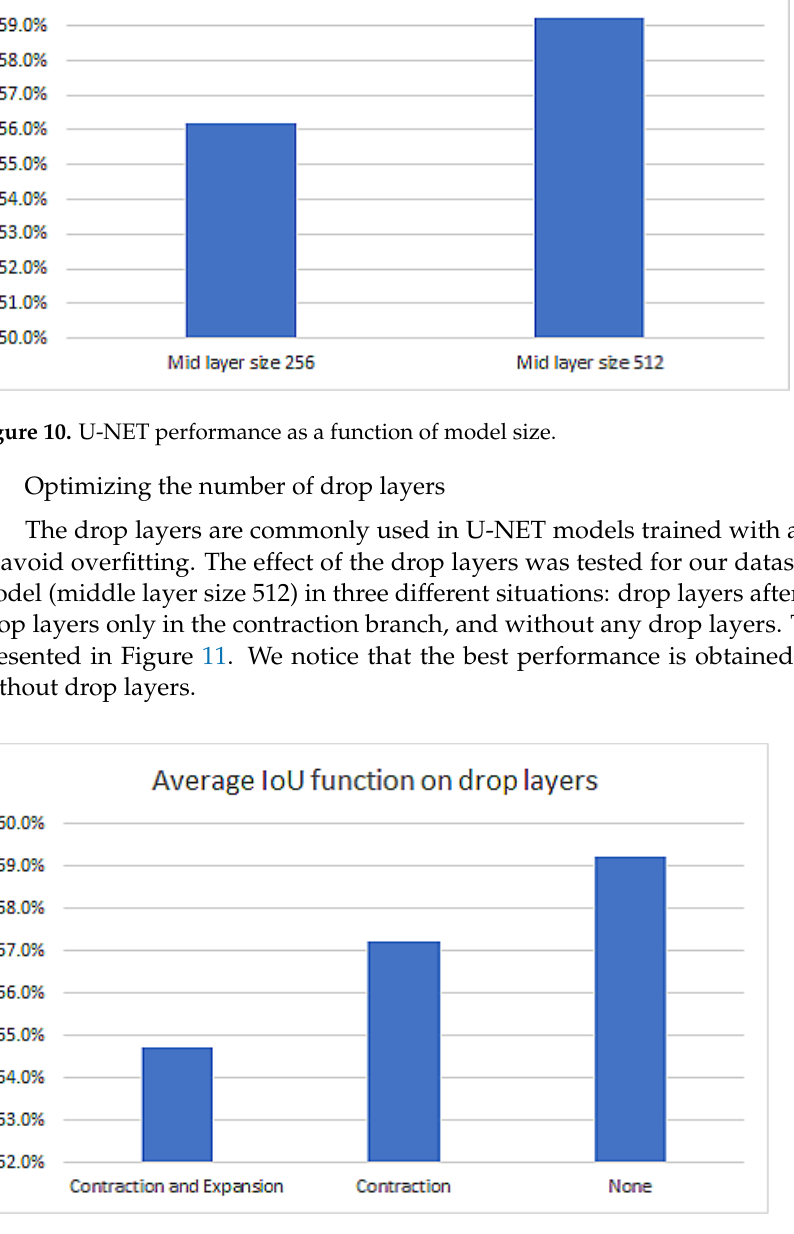
Figure 11. U-NET performance as a function of employed drop layers.